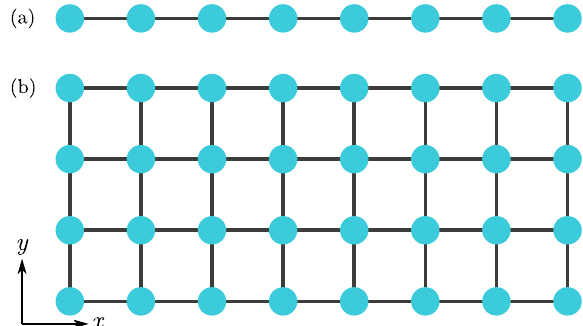
Fig. 4 Qubit layouts. a Linear layout with N = 8 and b rectangular layout with nearest-neighbor connectivity with ( l x , l y ) = (8, 4). Qubits are depicted as circles and lines indicate pairs between which a two- qubit operation is